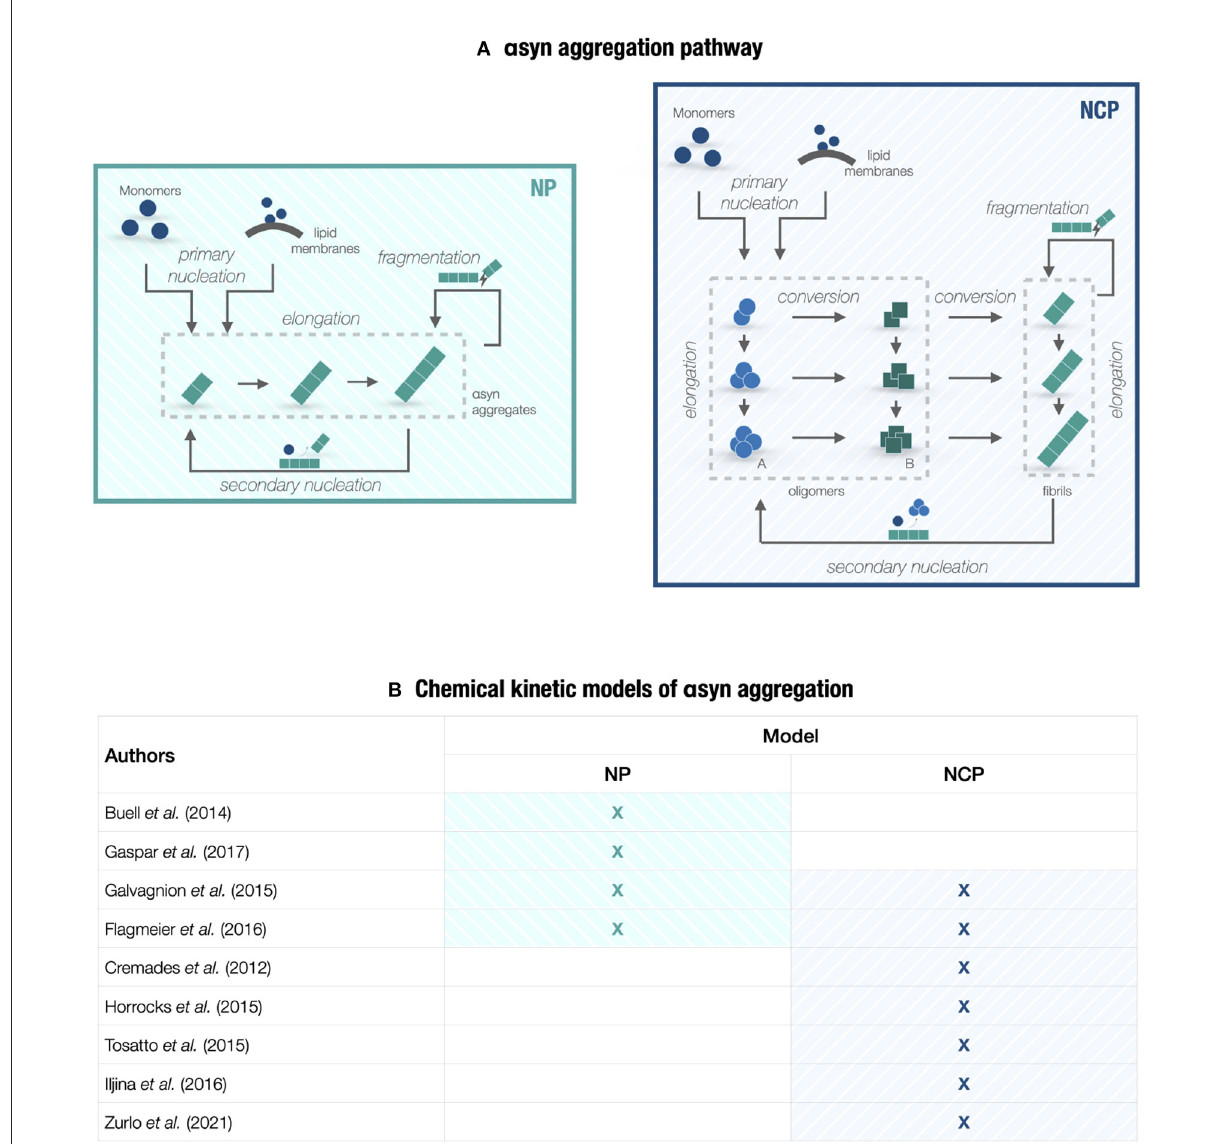
FIGURE1 Chemical kinetic models of α syn aggregation. (A) A conceptual scheme of the PD molecular landscape underlying models in Section 2. The kinetic of α syn aggregation can be represented by either a nucleation-polymerization (NP) process or a nucleation-conversion-polymerization (NCP) process. The pathway includes homogeneous primary nucleation from monomers, heterogeneous primary nucleation catalyzed by lipid membranes, aggregate elongation by monomer addition, structural conversion between oligomeric species (type-A and type-B oligomers) and fibrillar species (if we consider NCP models), fibril fragmentation, and heterogeneous secondary nucleation on fibril surfaces. Reverse processes, such as monomer dissociation and reverse conversion, are not shown since they are negligible at the early aggregation steps. (B) Table collecting the chemical kinetic models of α syn aggregation considered in Section 2 that provide mechanistic insights into PD neurodegeneration. The studies are based on the master equation approach and focus either on NP or NCP